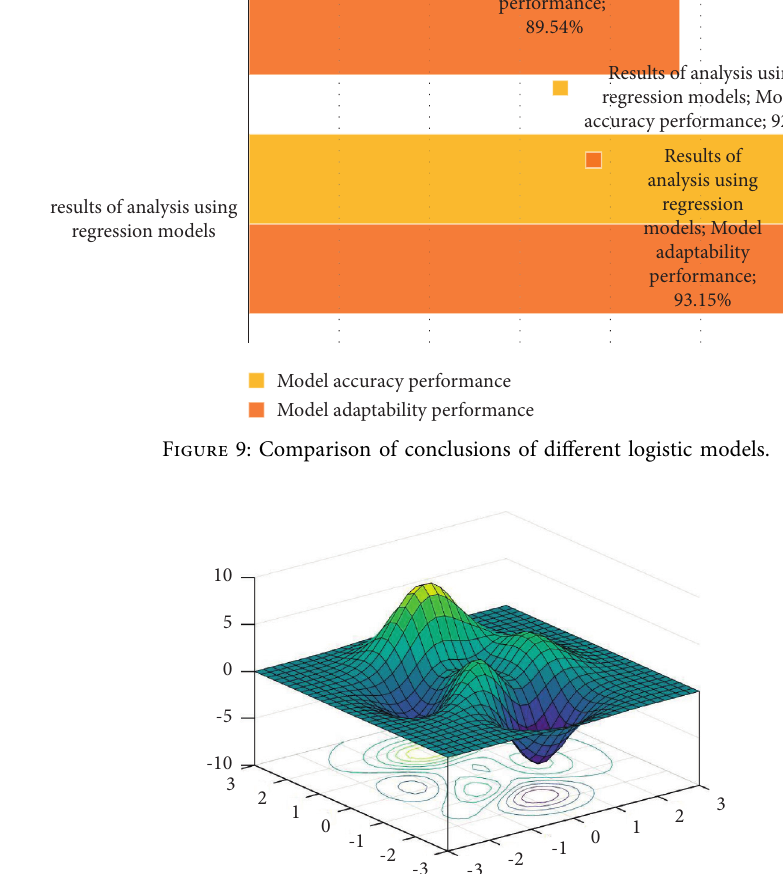
Figure 10: Experimental comparison results using different logistical networks.